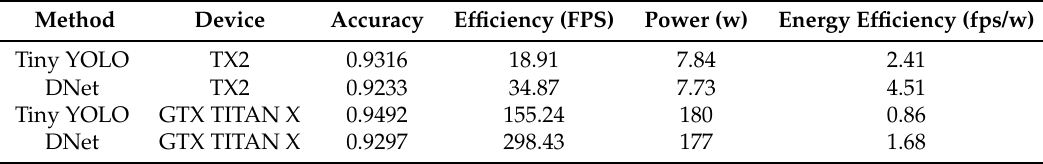
Table 3. Test results of Tiny YOLO and DNet.